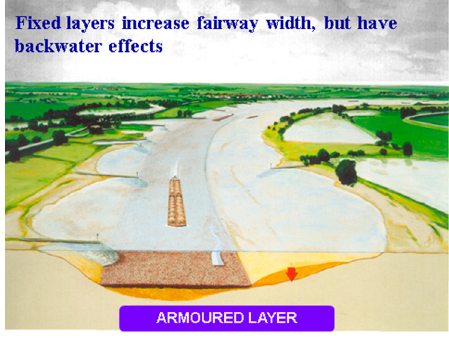
Figure 13. Fixed layer in outer bend (copyright Kees Nuijten).